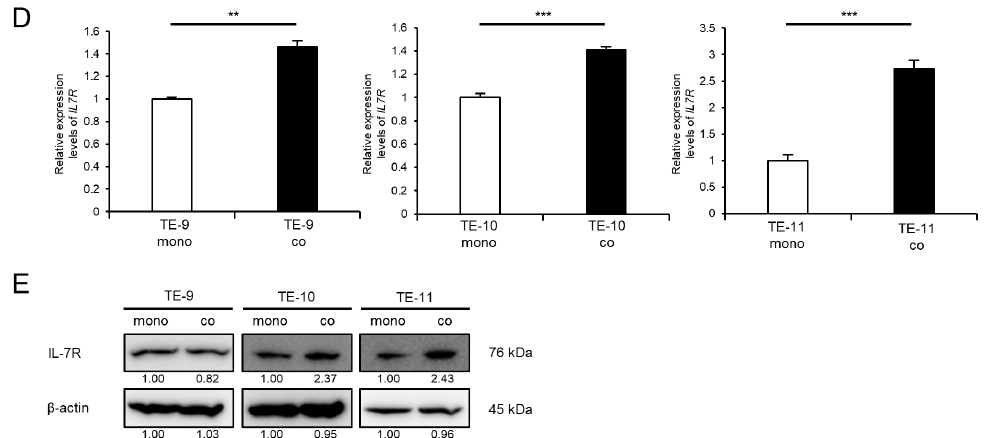
Figure 1. Effects of direct co-culture with macrophages on ESCC cell lines. ESCC cells were directly co-cultured with macrophages for 2 days and then separated from macrophages. ( A , B ) Survival assays ( A ) and growth assays ( B ) were performed to investigate the effects of direct co-culture. The three graphs compare the survival and growth of TE-9, -10, and -11 cells co-cultured with macrophages with those of monocultured TE-9, -10, and -11 cells, respectively. ( C ) Western blot analyses were performed to investigate the signaling pathways activated in TE-9, -10, and -11 cells by direct co-culture with macrophages. β -actin was used as an internal control. The expression level was normalized using ImageJ software, and the relative value was set as 1.00 for monocultured ESCC cells. ( D ) The expression levels of IL7R mRNA in TE-9, -10, and -11 cells monocultured and co-cultured with macrophages were confirmed by qRT-PCR. GAPDH was used as an internal control. ( E ) The expression levels of IL-7R protein in TE-9, -10, and -11 cells monocultured and co-cultured with macrophages were confirmed by Western blot analyses. β -actin was used as an internal control. The expression level was normalized using ImageJ software, and the relative value was set to 1.00 for monocultured ESCC cells. Data are presented as the mean ± SEM. N.S., not significant. ** p < 0.01, *** p <